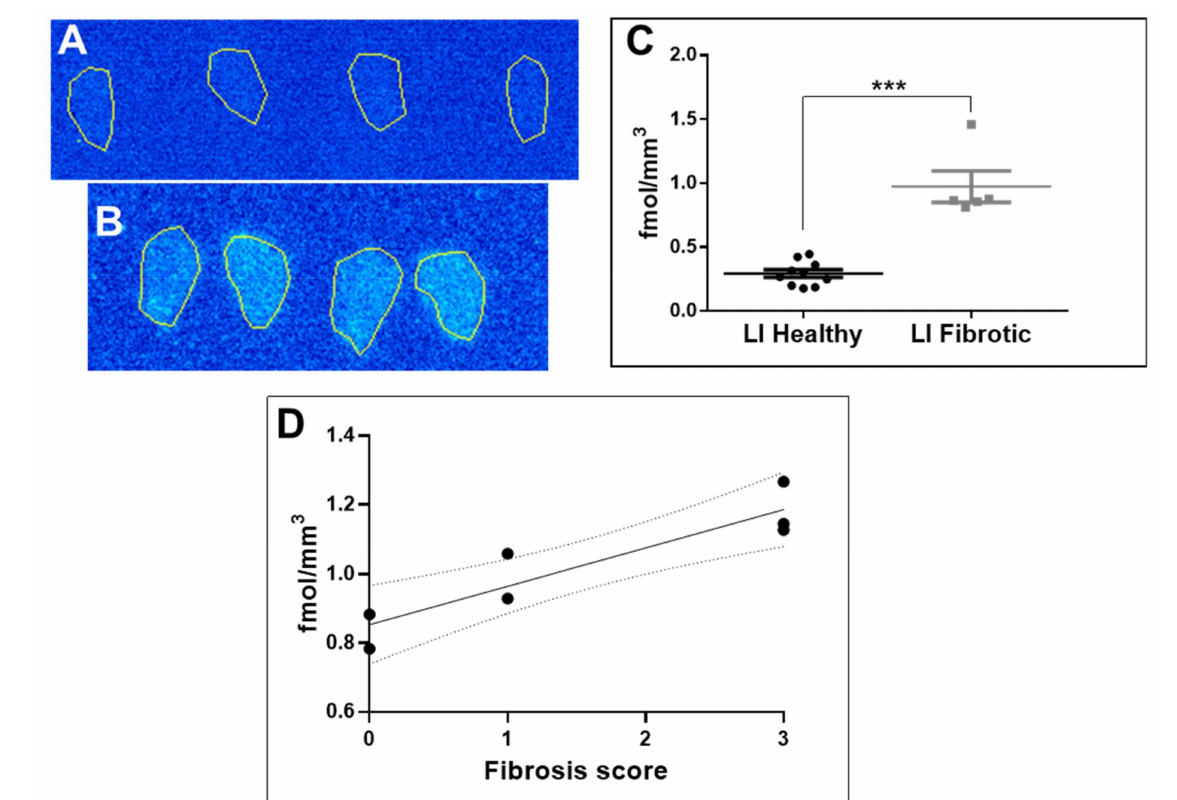
Figure 2. ( A ) Autoradiography of a frozen section of a normal mouse liver (a representative example). ( B ) Autoradiography of a frozen section of a liver of a mouse with induced liver fibrosis (a representative example). ( C ) Mann–Whitney test demonstrating the statistically significant difference ( p = 0.0007; *** denotes values <0.001) between the uptake in the liver tissue of the healthy mice and mice with induced liver fibrosis. ( D ) Correlation of [ 68 Ga]Ga-NO2A-[Nle13]-Col uptake in fibrotic mouse liver cryosections measured by autoradiography with a fibrosis score estimated by Sirius Red staining (R 2 = 0.84; p =